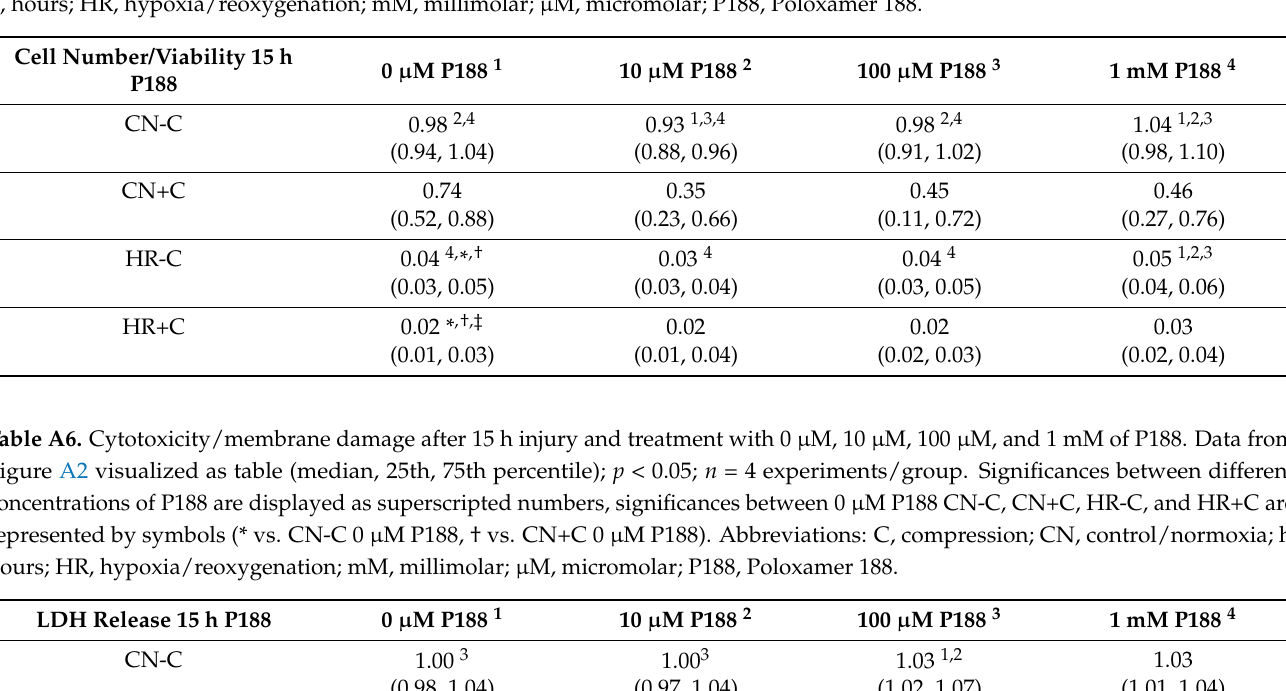
Table A5. Cell number/viability after 15 h injury and treatment with 0 µ M, 10 µ M, 100 µ M, and 1 mM of P188. Data from Figure A1 visualized as table (median, 25th, 75th percentile); p < 0.05; n = 4 experiments/group. Significances between different concentrations of P188 are displayed as superscripted numbers, significances between 0 µ M P188 CN-C, CN+C, HR-C, and HR+C are represented by symbols (* vs. CN-C 0 µ M P188, † vs. CN+C 0 µ M P188, ‡ vs. HR-C 0 µ M P188). Abbreviations: C, compression; CN, control/normoxia;